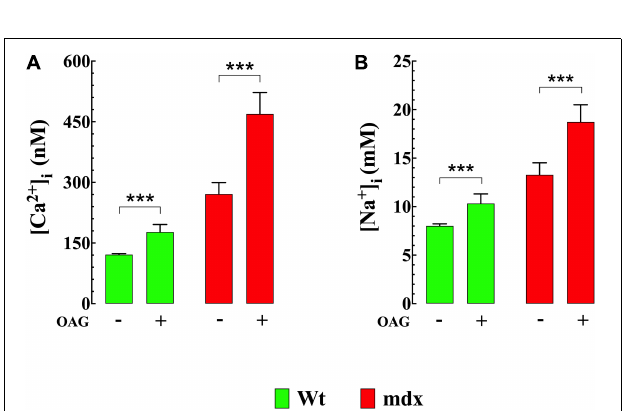
FIGURE 3 | OAG induces elevation of [Ca 2 + ] i and [Na + ] i . Exposure of quiescent Wt and mdx VSMc to 1-oleoyl-2-acetyl-sn-glycerol (OAG) 100 µ M induced a significant elevation of [Ca 2 + ] i (A) and [Na + ] i (B) , which were greater in mdx than Wt muscle cells. Over the horizontal axis are indicated the experimental conditions used to measure [Ca 2 + ] i and [Na + ] i . For [Ca 2 + ] i measurements: n mice = 4/experimental condition, n cell = 21–27/genotype. For [Na + ] i measurements: n mice = 3/experimental condition, n cell = 23–25/genotype. Values are expressed as means ± S.D. for each condition. Student’s t -test *** p ≤ 0.001.